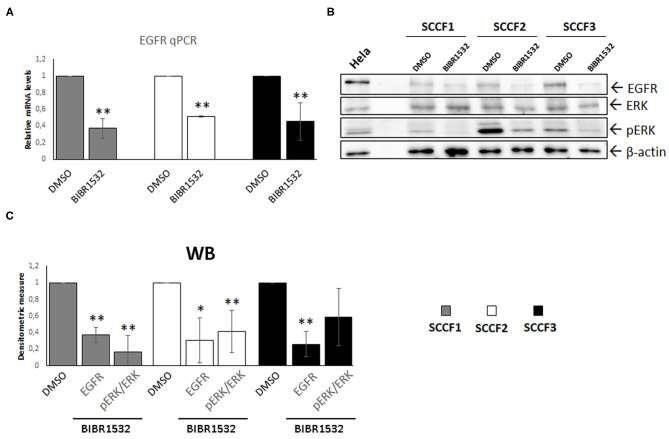
BIBR1532 down-regulates EGFR pathway in FOSCC cell lines. (A) SCCF1, SCCF2, and SCCF3 were treated with BIBR1532 50 μM vs. DMSO and analyzed by qPCR for EGFR gene expression. Data were normalized for β2-microglobulin and expressed as relative quantization by the 2−ΔΔCt method. Changes in relative mRNA levels were calculated for SCCF1, SCCF2, and SCCF3 treated with BIBR1532 compared with their respective DMSO control set as 1. Plots represent the mean ± standard deviations (SD) of at least three repeated, independent experiments performed in technical triplicate. (B) Representative WB for EGFR, ERK, and pERK in BIBR1532- vs. DMSO-treated cells. HeLa whole cell lysate run along with feline samples confirmed the identity of the bands. The blot was stripped and reprobed for β-actin to ensure comparable protein loading and allow normalization. (C) Densitometric values of EGFR normalized for β-actin and densitometric ratio pERK/ERK; data are expressed as mean ± SD from at least three repeated, independent experiments. Changes in protein levels were calculated for SCCF1, SCCF2, and SCCF3 treated with BIBR1532 compared with their respective DMSO control set as 1 (statistically significant, *P < 0.05 and **P < 0.01).